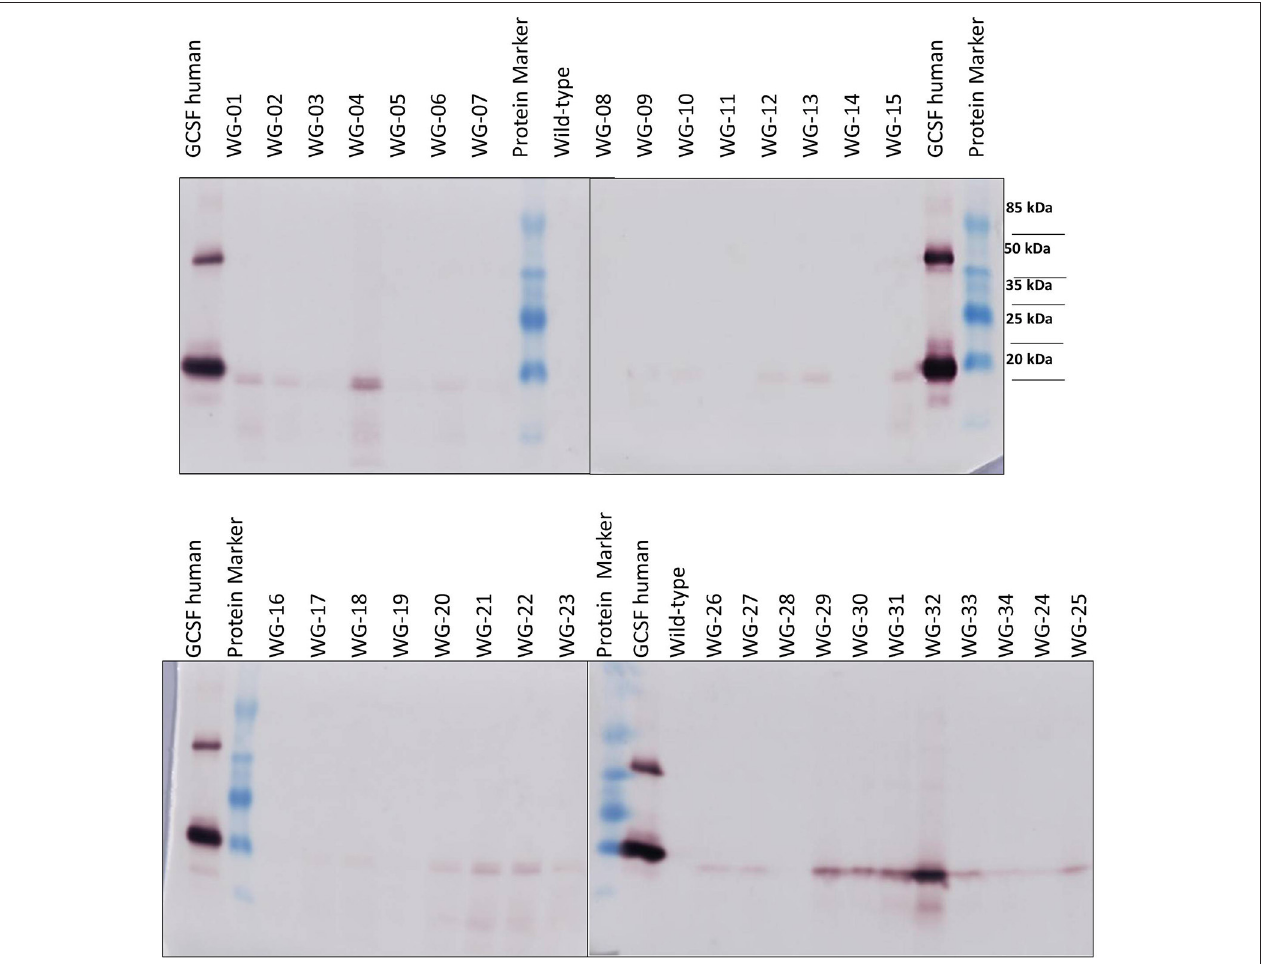
FIGURE 5 | Western blot analysis of hG-CSF expression in some transgenic Wolffia lines. Protein Marker, molecular size marker TS 26612 Protein MW Marker; GCSF human, recombinant human G-CSF (200 ng; AbCam, UK).